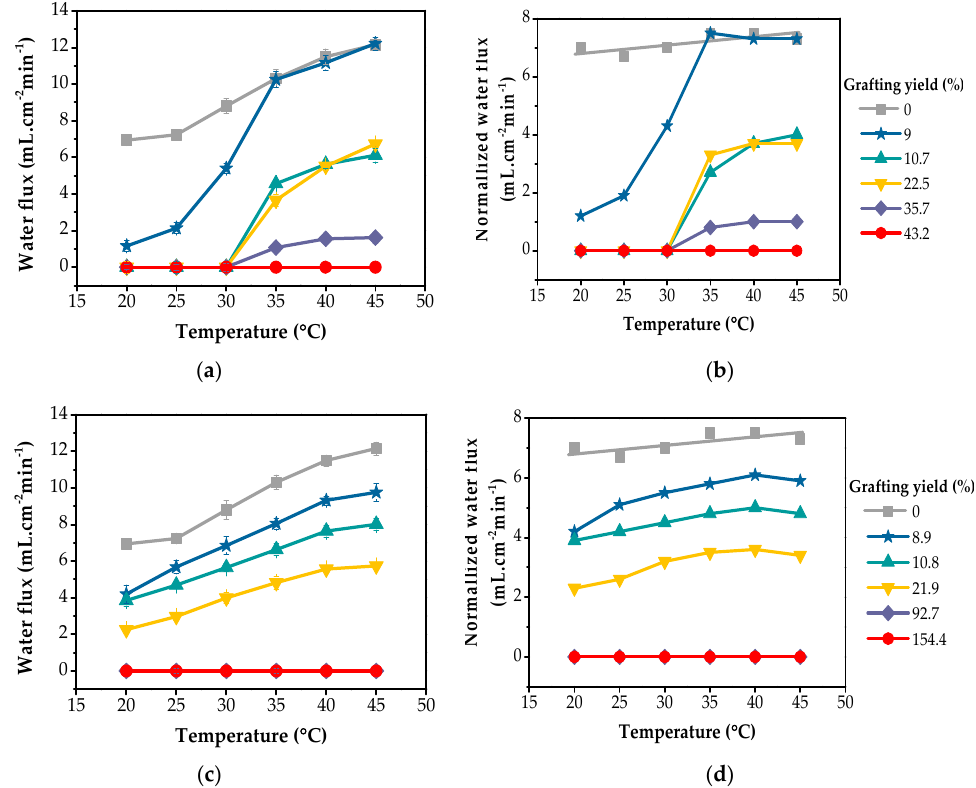
Figure 7. Thermoresponsive characteristics of water flux through PNIPAm-grafted nylon mem- branes with different grafting yields before and after normalization of: ( a , b ) linear; ( c , d ) crosslinked structure, respectively .